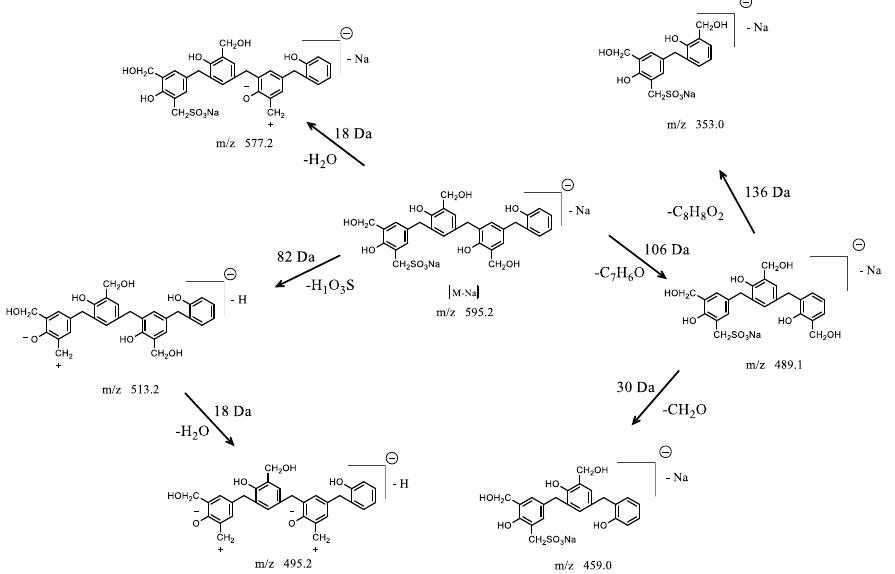
Figure 8. Proposed fragmentation pathway for the molecular ion with mass-to-charge ratio of m/z 595.2.